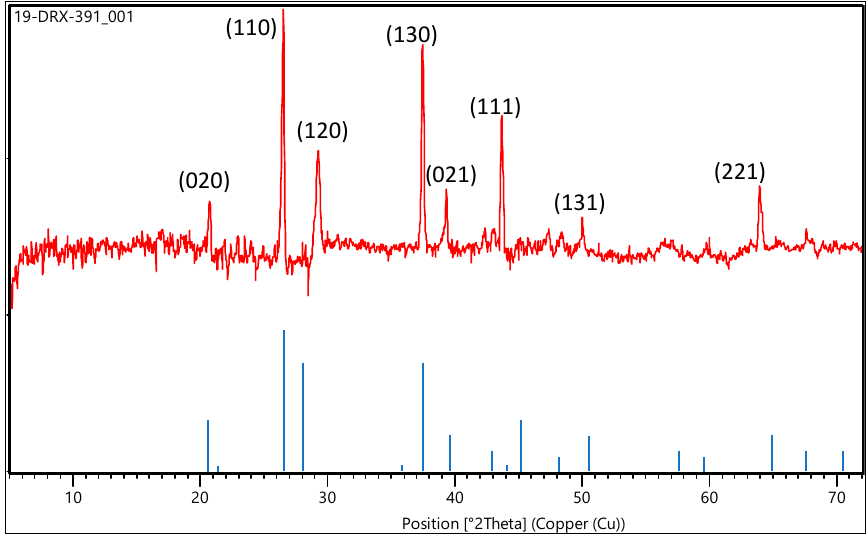
Figure 2. XRD patterns of the generated nanoparticles.